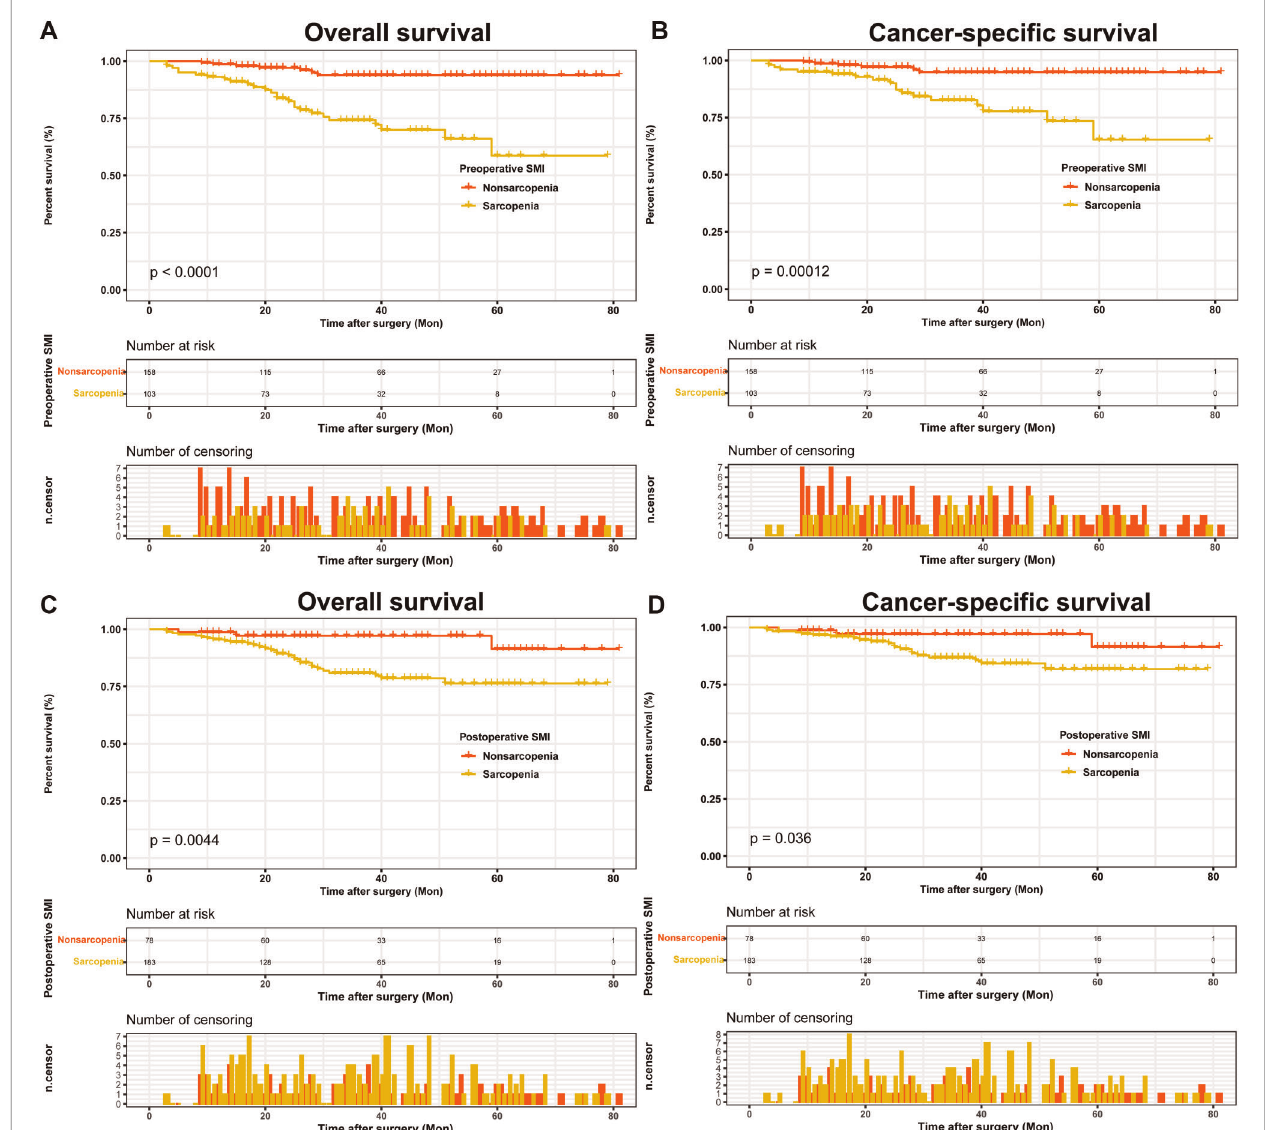
FIGURE 2 | Kaplan-Meier curves for OS and CSS strati fi ed by pre- and postoperative SMI. ( A,B ) Preoperative SMI OS and CSS; ( C,D ) Postoperative SMI OS and CSS. Abbreviations: OS, overall survival; CSS, cancer-speci fi c survival; SMI, skeletal muscle